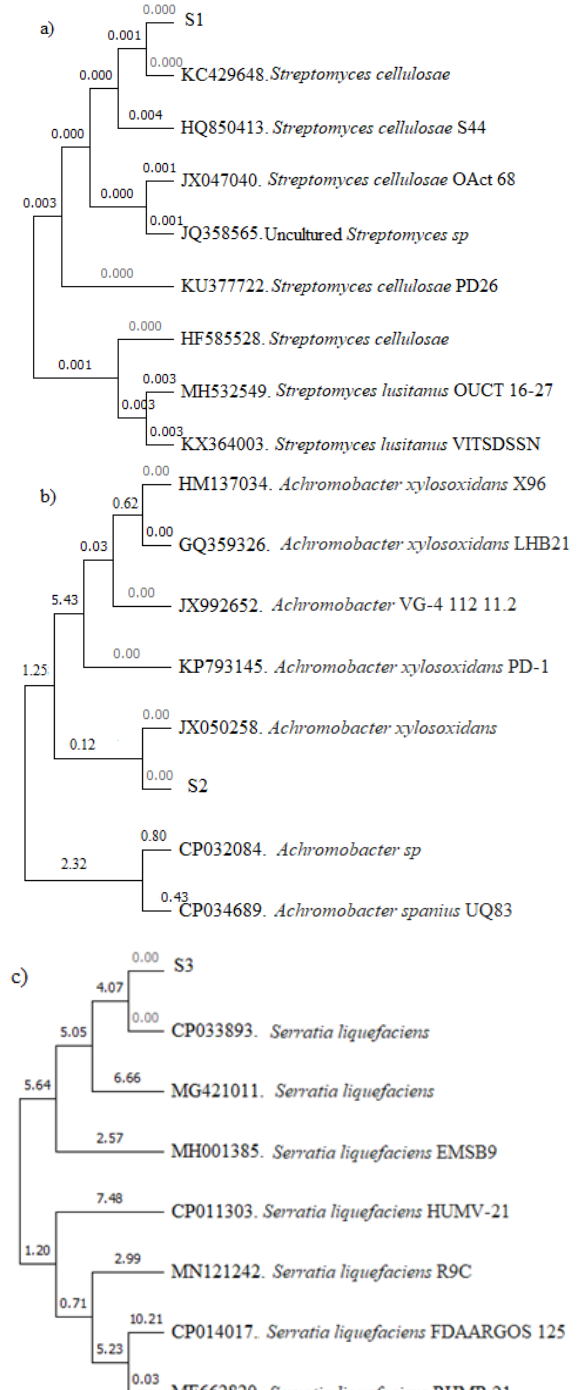
Figure 3. Neighbor-joining phylogenetic tree based on the 16S rRNA gene sequence of the isolates and other reference sequences (( a ) S1, ( b ) S2, and ( c ) S3) (Numbers in figures show branch lengths).